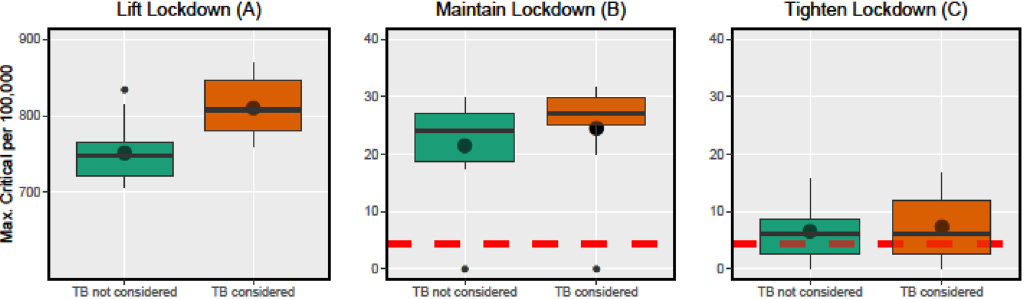
Figure 1. Policy impacts on peaks of critical cases (summary). Properties of the maximum number of critical cases throughout the epidemics for 130 days. The three policy scenarios are conducted and model lifting, maintaining and tightening the lockdown. Each scenario is simulated with and without consideration of TB as a risk factor to assess the impact. All policy scenarios start with 100 infected inhabitants and a default lockdown is applied until day 25. The dashed red lines represent the number of available ICUs. Each setup is based on ten